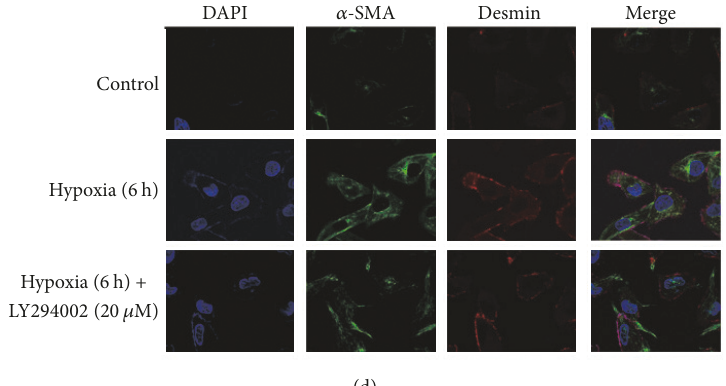
Figure 3: PI3K/AKT signaling blocks the inhibitory effect of PPAR 𝛾 on hypoxic-induced HSCs activation. Activation of PI3K with 740 Y-P (25 𝜇 g/ml) of HSCs exposed to hypoxia in the presence or absence of RSG (50 nM). (a) PPAR 𝛾 , 𝛼 -SMA, and desmin expression of HSCs in experimental groups were analyzed by western blotting. (b) 𝛼 -SMA and desmin expression of HSCs in experimental groups were detected by immunofluorescenceusingConfocalmicroscopy.InhibitionofPI3KwithLY294002(20 𝜇 M)inHSCsexposedtohypoxia.(c)Phosphorylated AKT, total AKT, PPAR 𝛾 , 𝛼 -SMA, and desmin expression of HSCs in experimental groups were measured by western blotting. (d) 𝛼 -SMA and desmin expression of HSCs in experimental groups were detected by immunofluorescence using Confocal microscopy. For each assay, 𝑛 = 3 . ∗ 𝑃 < 0.05 , ∗∗ 𝑃 < 0.01 .